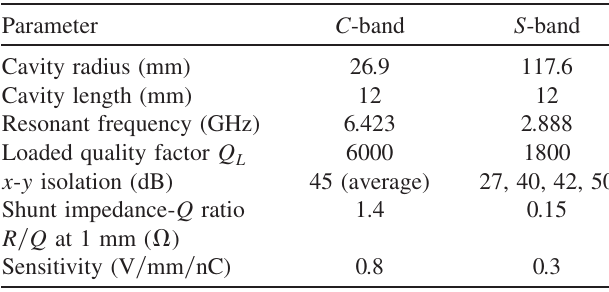
TABLE II. Cavity parameters for C - and S -band devices. Frequencies and isolation measured in air, while Q are values from electromagnetic simulation.